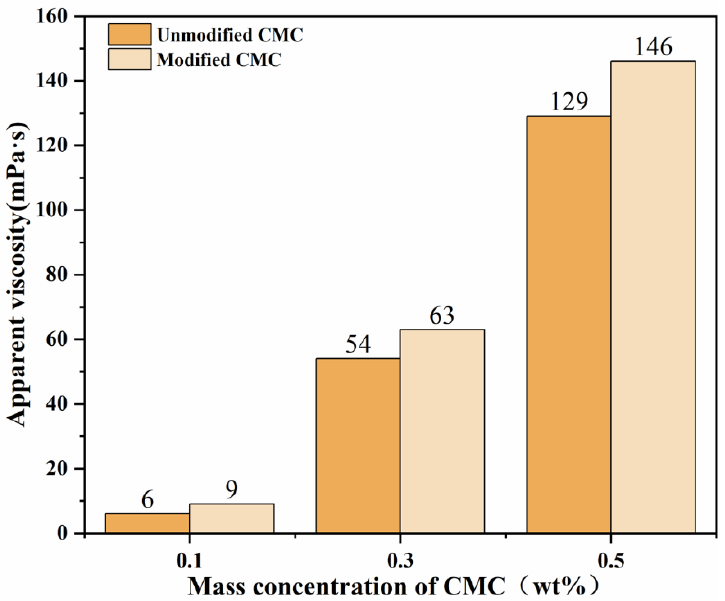
Figure 13. Apparent viscosity of modified CMC and unmodified CMC in 10,000 ppm Na + salinity water.